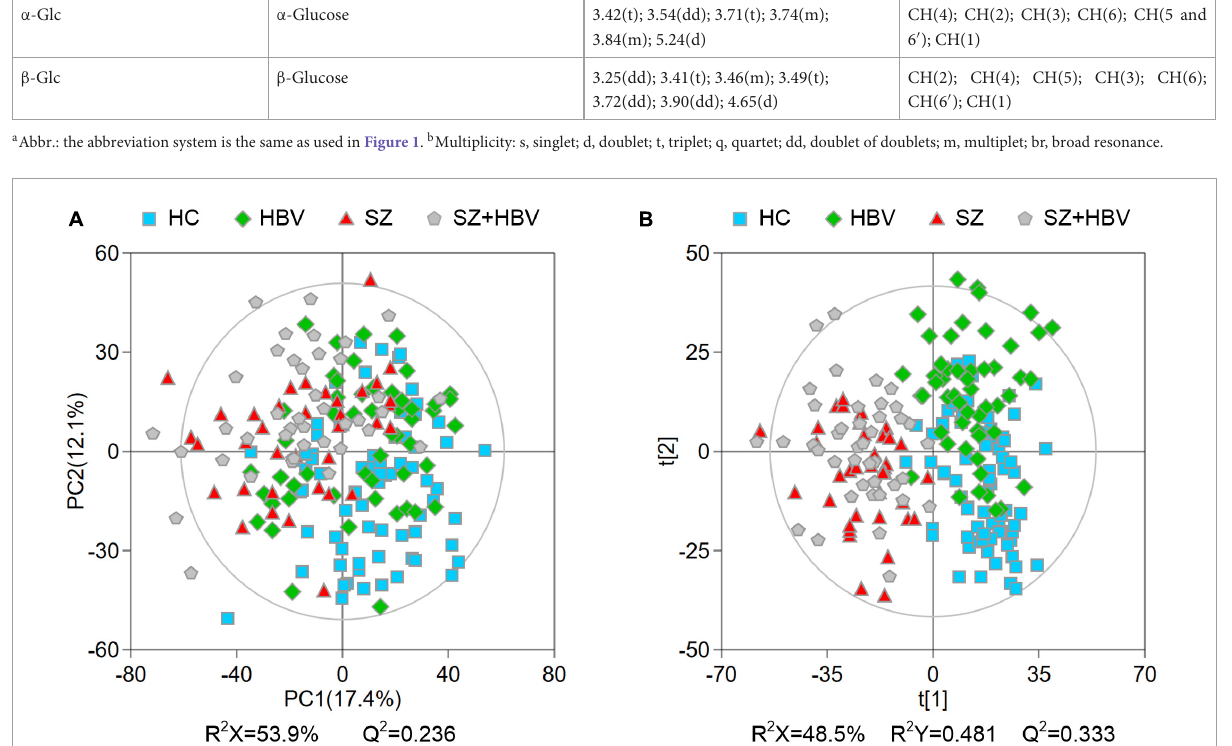
cycle , arginine , and proline metabolism , butyrate metabolism , carnitine synthesis , ketone body metabolism ,